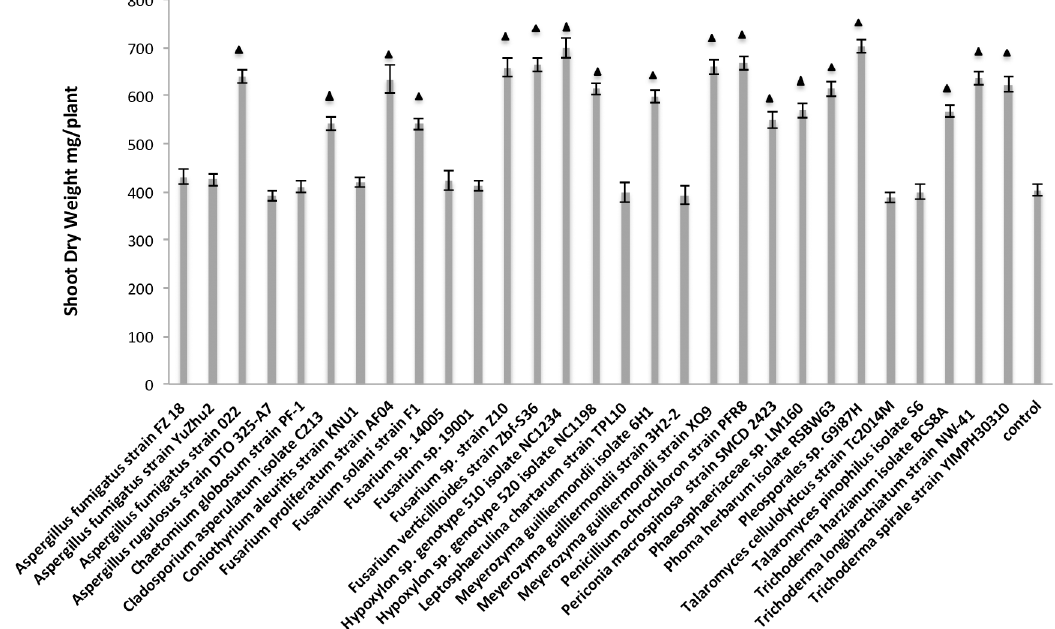
Fig 4. The shoot dry weights of the switchgrass plants. The plants were treated with water control and the water broth containing diverse fungal spores and mycelia at 8 weeks under greenhouse condition. The triangle represents the significant difference existing between the fungal broth treated and water treated plants; the data were further analyzed by the Student’s t-test (P <